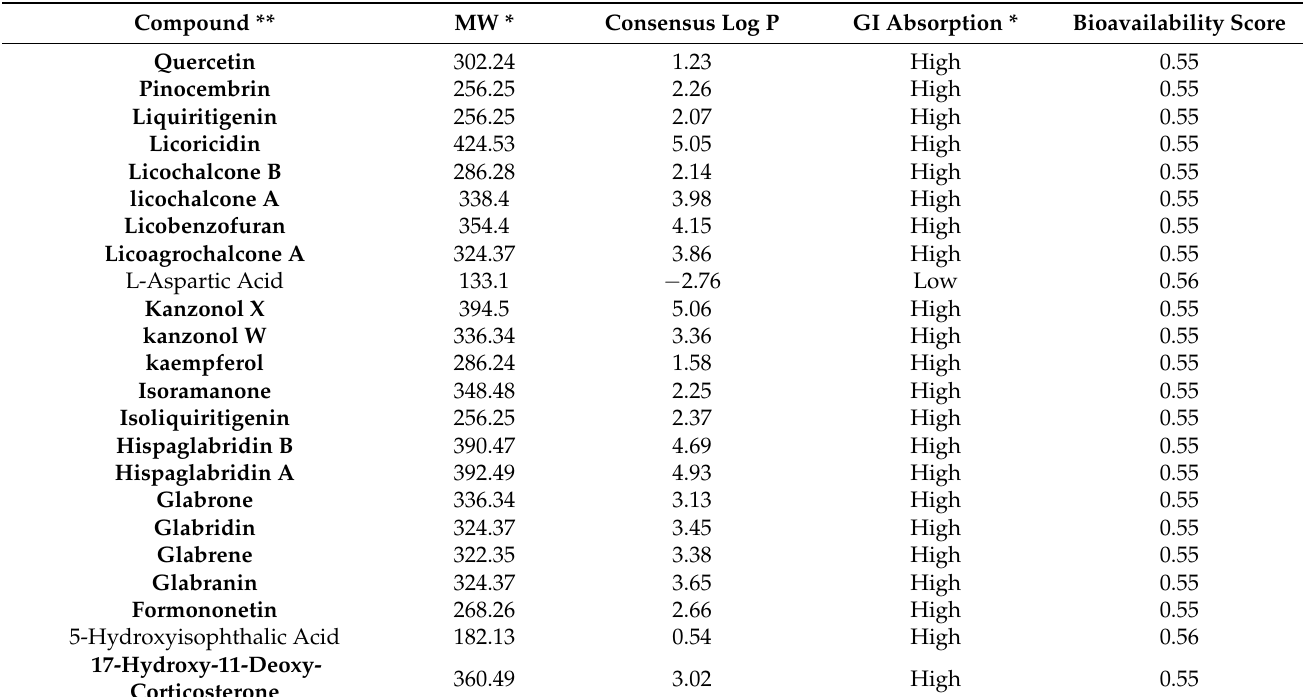
Table 1. ADME evaluation about 23 compounds by